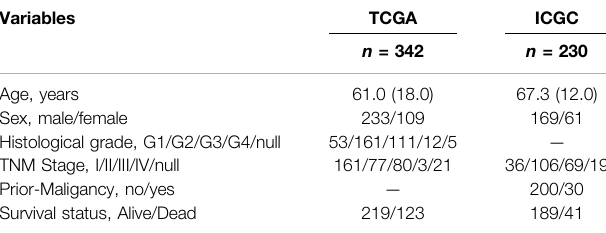
TABLE 1 | Baseline characteristics of HCC patients included in this